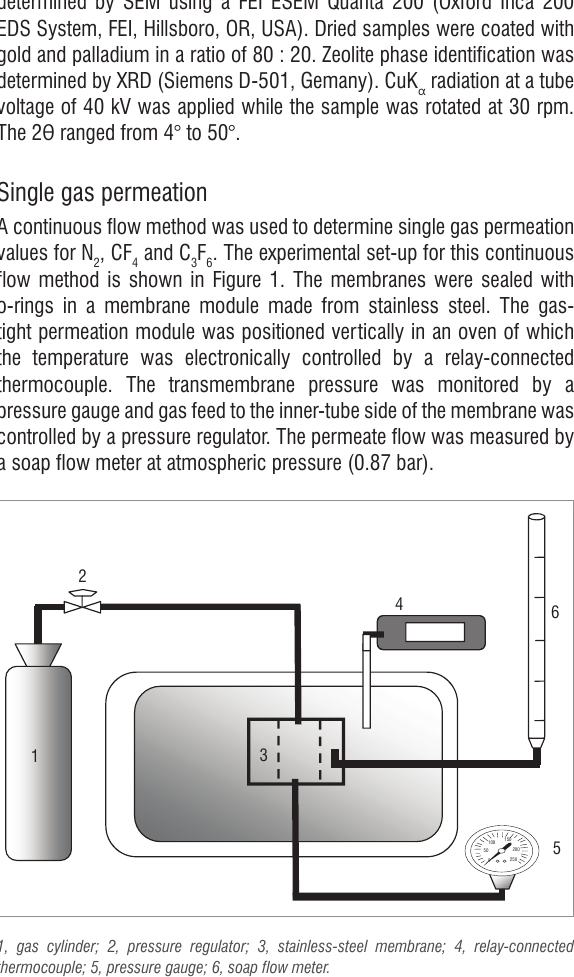
Figure 1: The experimental set-up for the single gas permeation